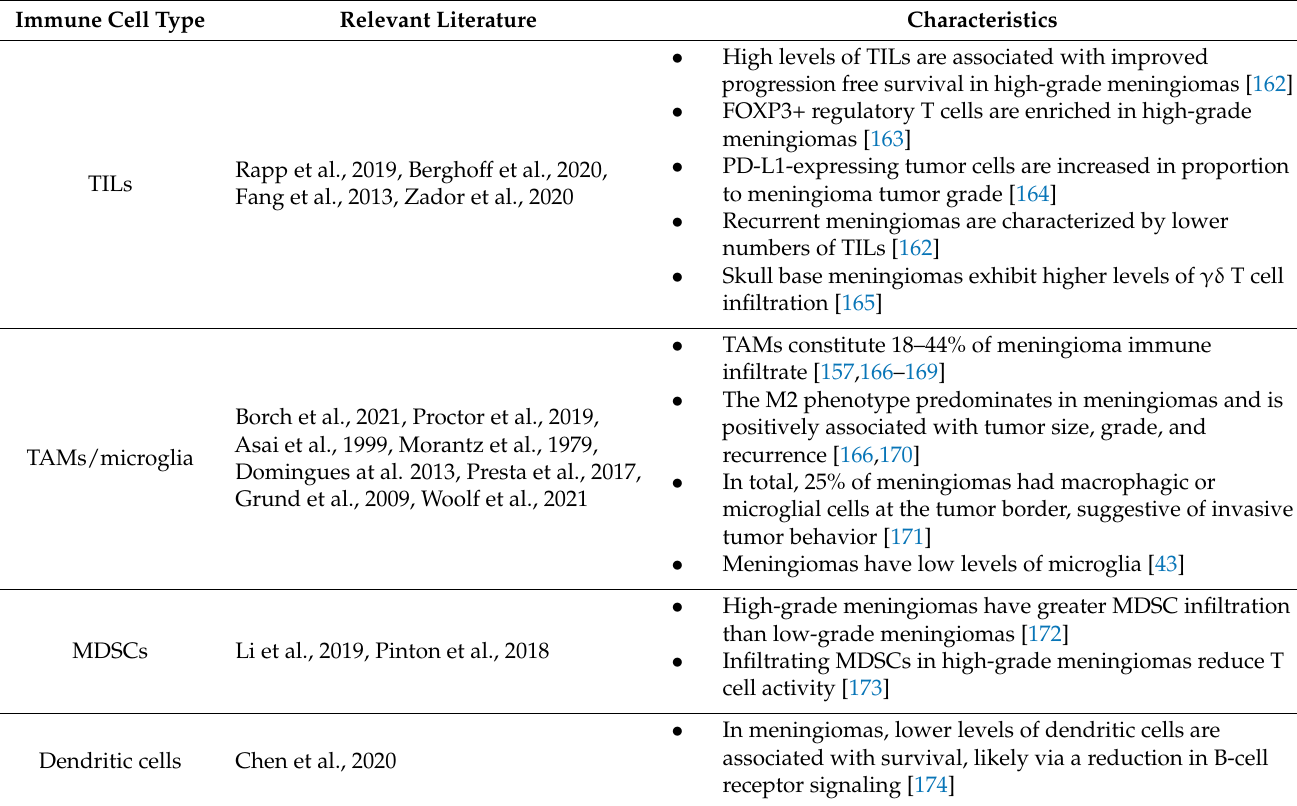
Table 3. Summary of immune cell infiltration of